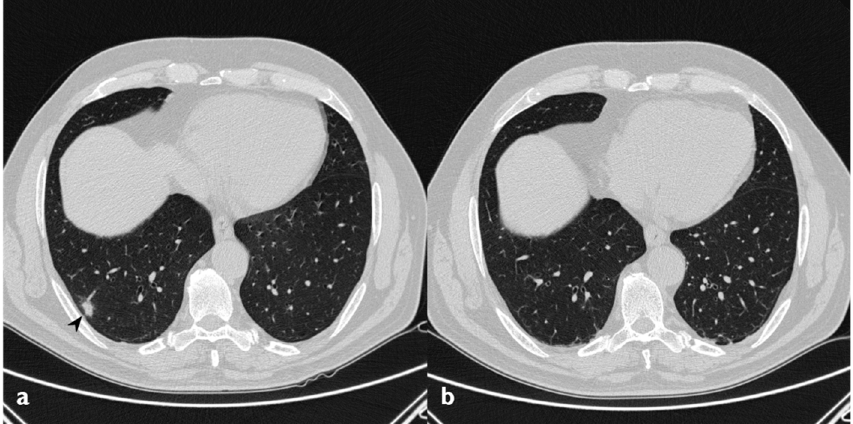
Figure 11. On the left ( a ): baseline HRCT; peripheral solid nodule in the right lower lobe (arrowheads).